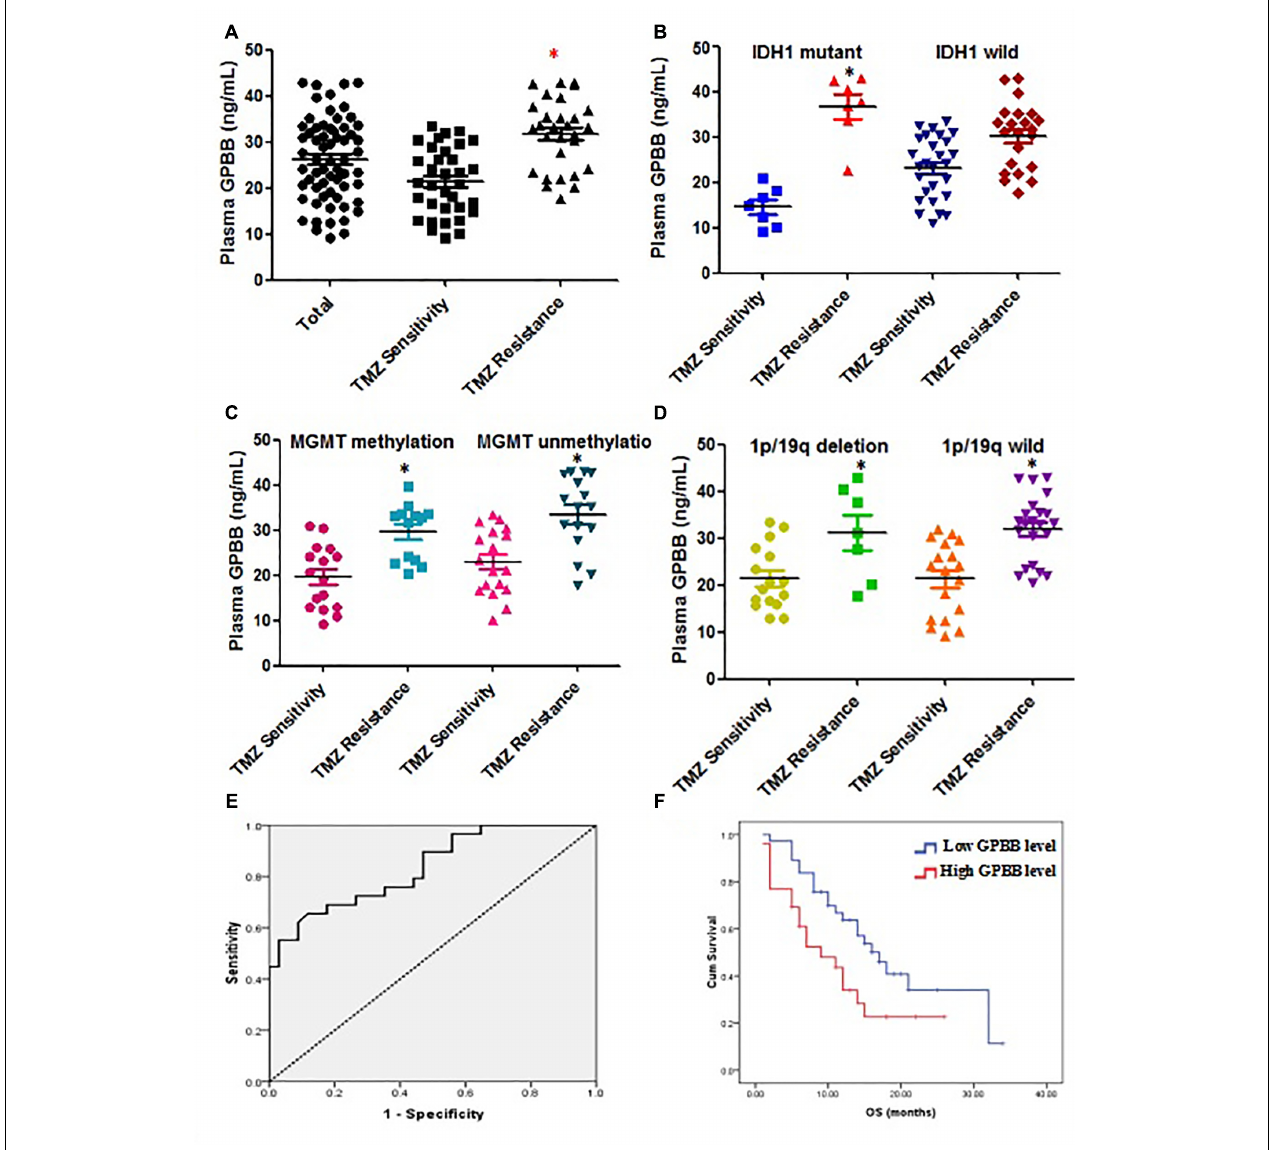
FIGURE 1 | Elevated plasma glycogen phosphorylase BB (GPBB) concentrations in high-grade glioma patients with TMZ resistance compared to those with TMZ sensitivity. Plasma GPBB concentration was measured before surgery. (A) Plasma GPBB concentration in toto , TMZ-sensitive and TMZ-resistant cohorts. (B) Plasma GPBB concentration in IDH1 mutant and IDH1 wild cohorts. (C) Plasma GPBB concentration in MGMT methylation and MGMT non-methylation cohorts. (D) Plasma GPBB concentration in 1p/19q co-deletion and 1p/19q wild cohorts. (E) ROC curve analysis of plasma GPBB concentration in response to TMZ. All values are expressed as means ± SEM, indicated by vertical bars. ∗ Indicates a statistically significant ( P < 0.05) difference from TMZ-sensitivity group. (F) Survival curve showing overall survival (OS) for high-grade glioma patients with high levels or low levels of plasma